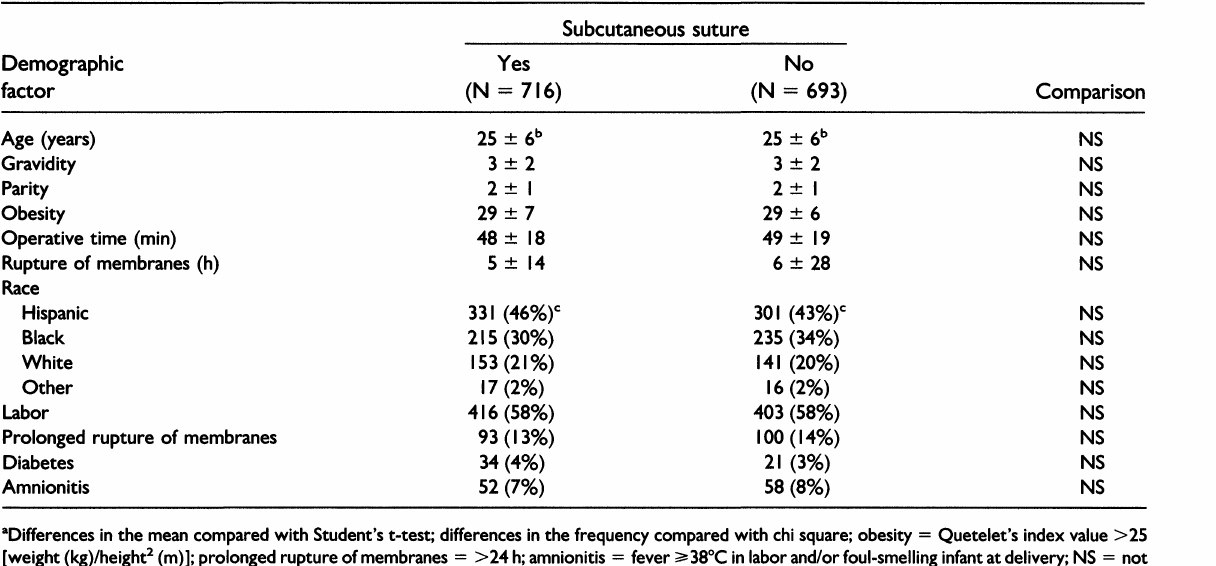
TABLE I. Pregnancy demographics in 1,409 women with and without subcutaneous sutures at cesarean section